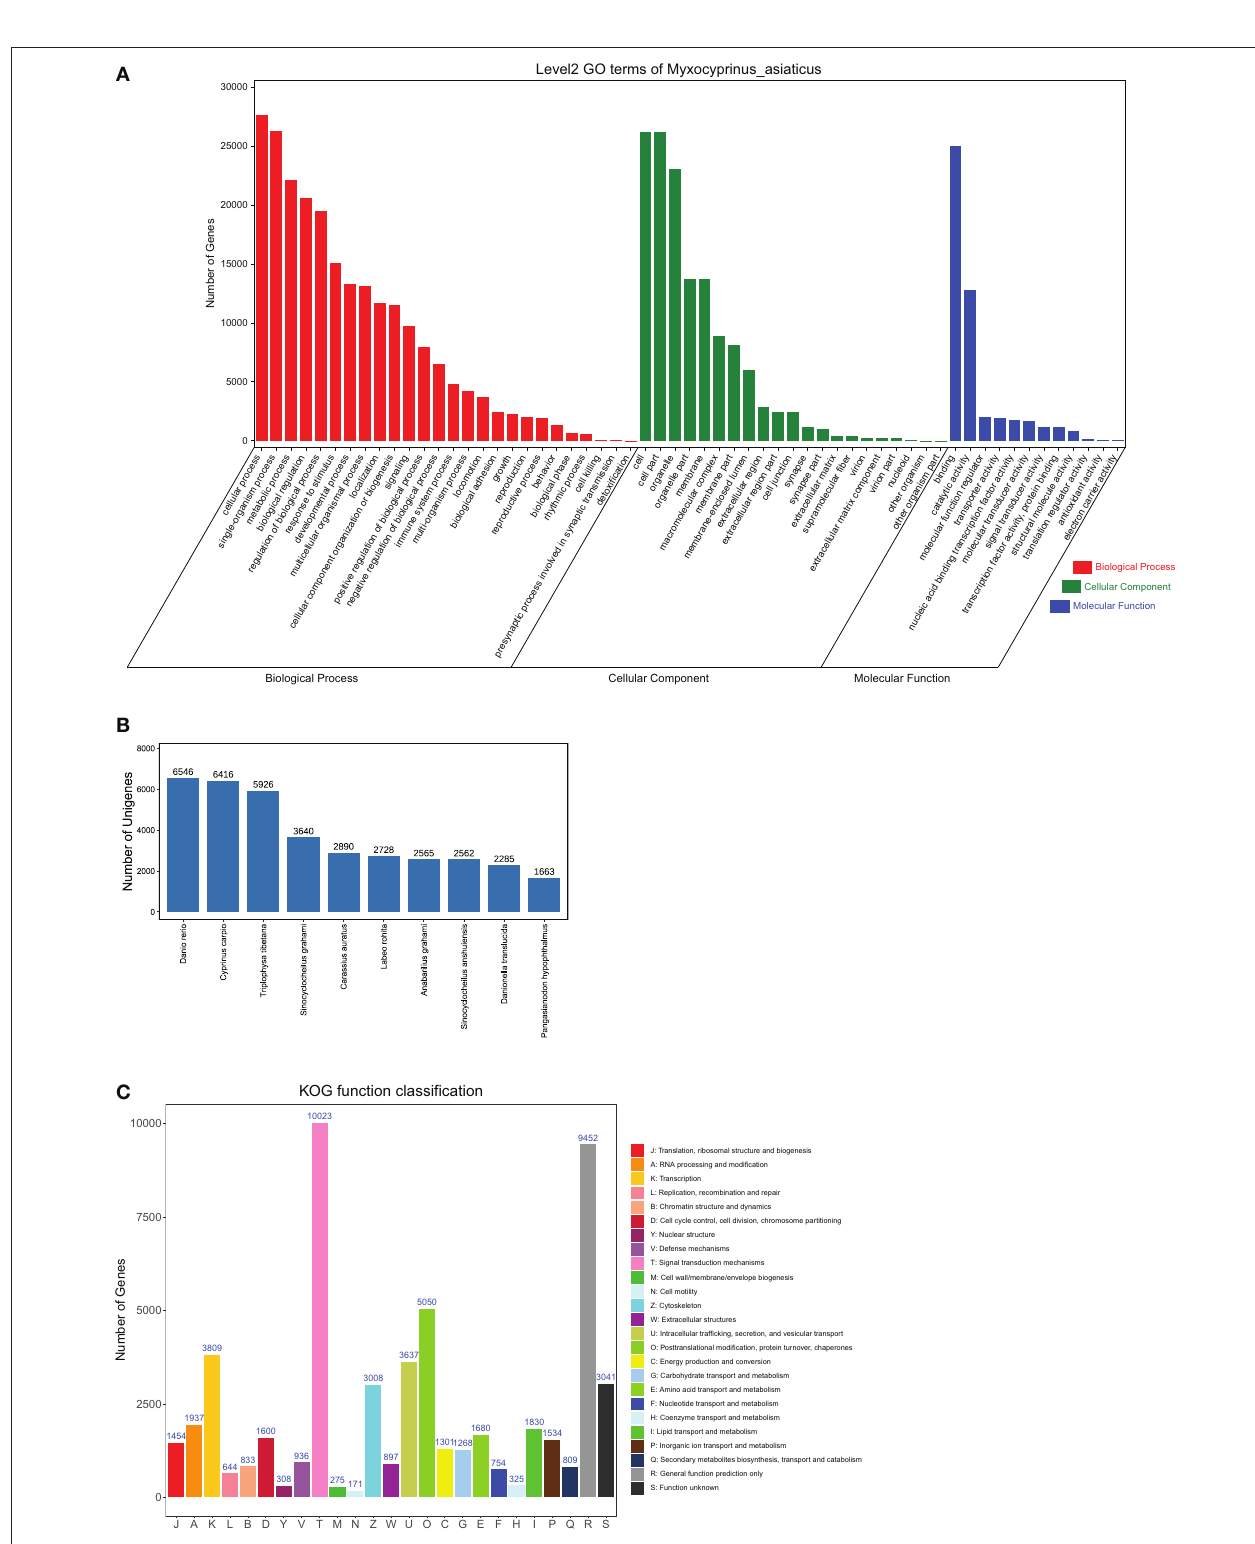
FIGURE 1 | Functional classification. (A) 2 level of GO functional annotations of full-length transcripts. (B) Protein taxonomic distribution annotated by non-redundant protein database. (C) Function classification annotated in KOG database.